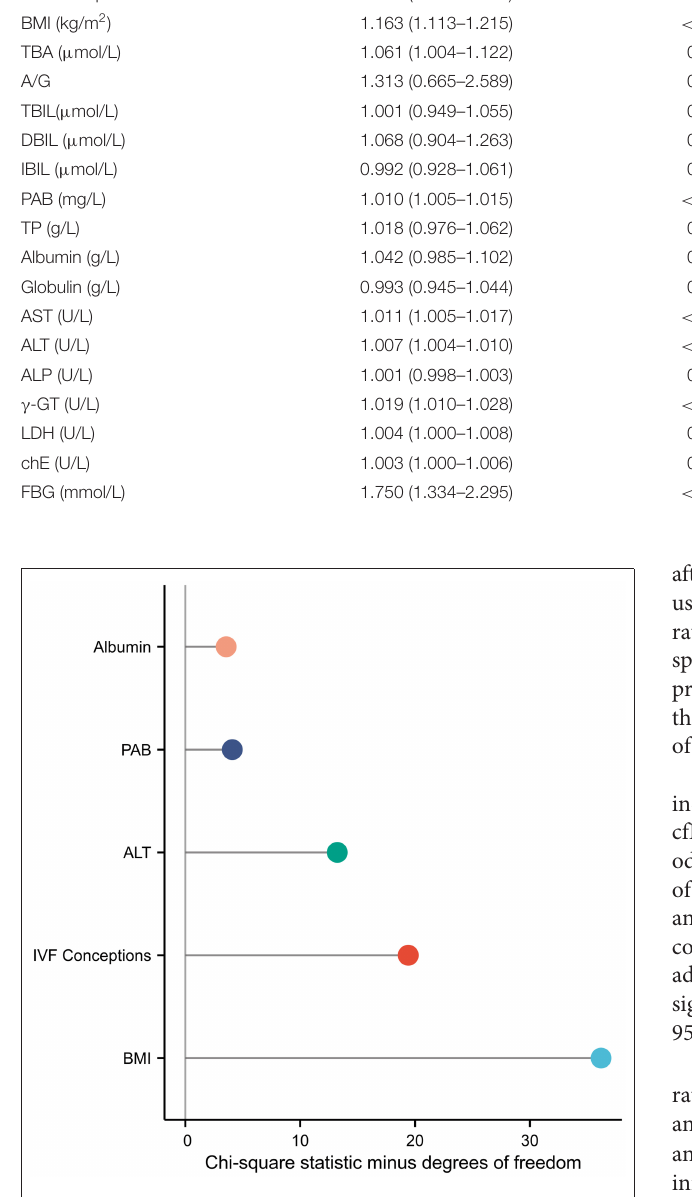
FIGURE 1 | Each factor’s contribution in the multivariable logistic regression analysis was measured as the chi-square statistic minus the degree of freedom of the